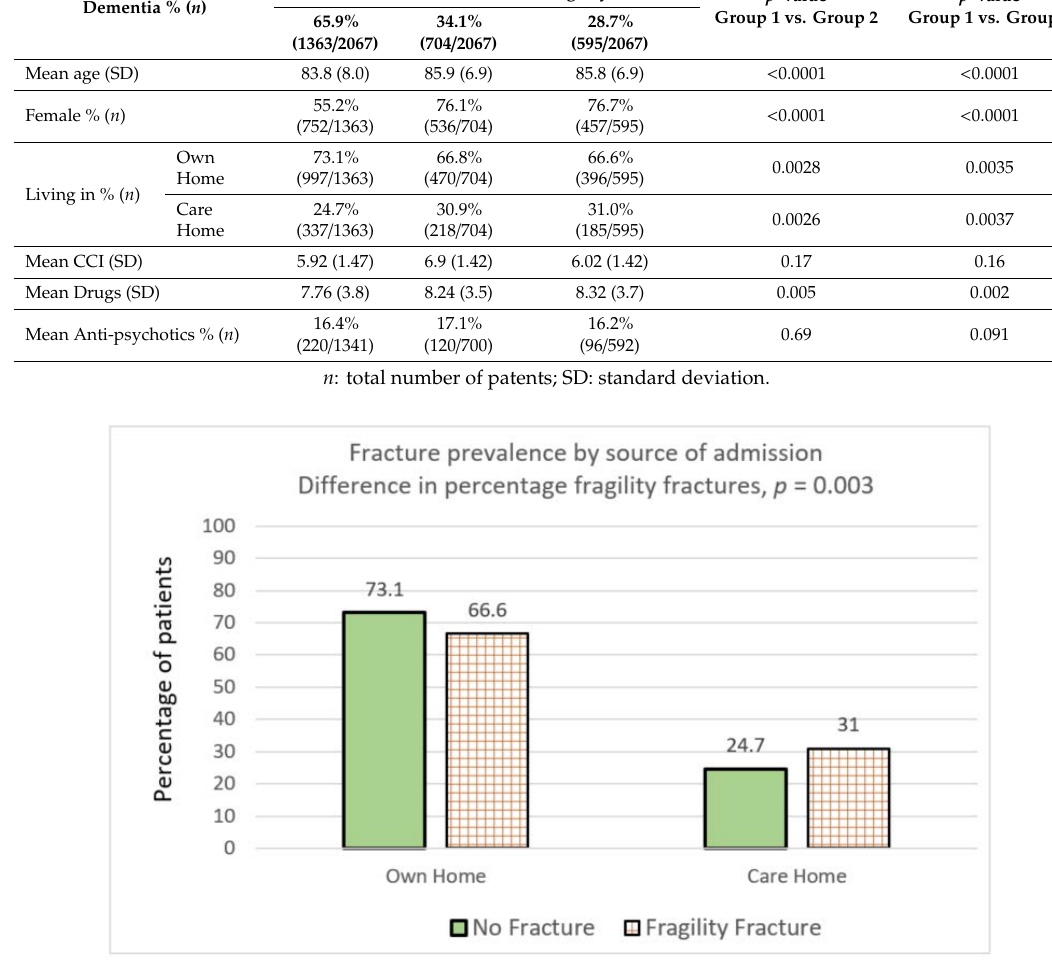
Table 2. Clinical outcomes and hip fracture data.